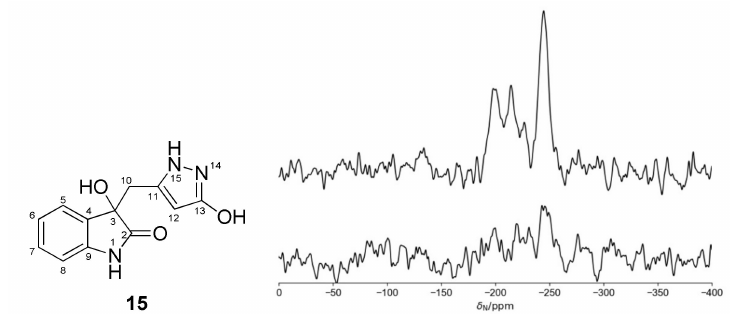
Figure 4. Structure of the desired material 15 and its 15 N- cross polarisation (CP) (top) and cross- polarisation polarisation-inversion (CPPI) (bottom) MASNMR